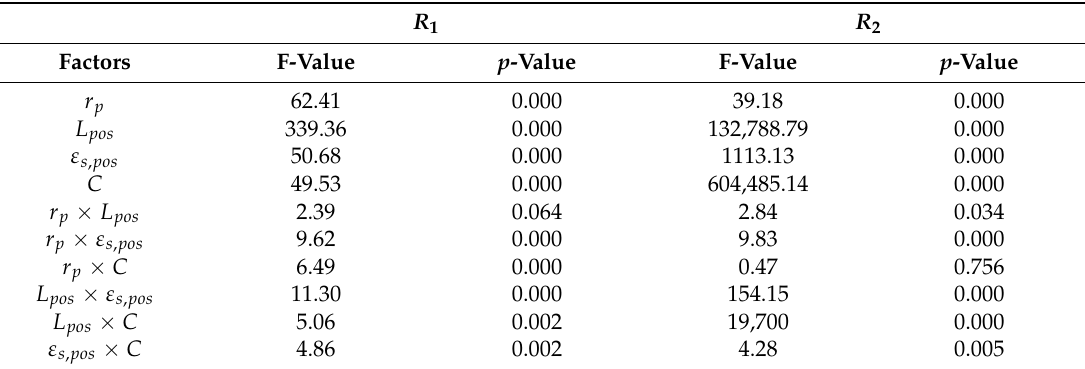
Table 3. The analysis of variance (ANOVA) results of the responses, R 1 (Specific energy) and R 2 (specific power) for the full factorial